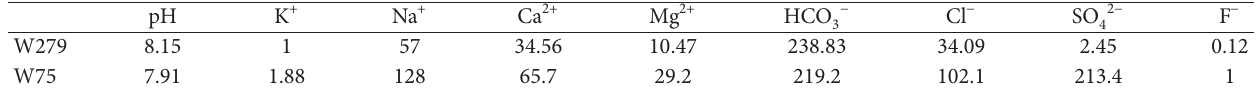
F 2: Piper plot of groundwater samples. T 2: Groudwater chemical analysis results in the simulation path